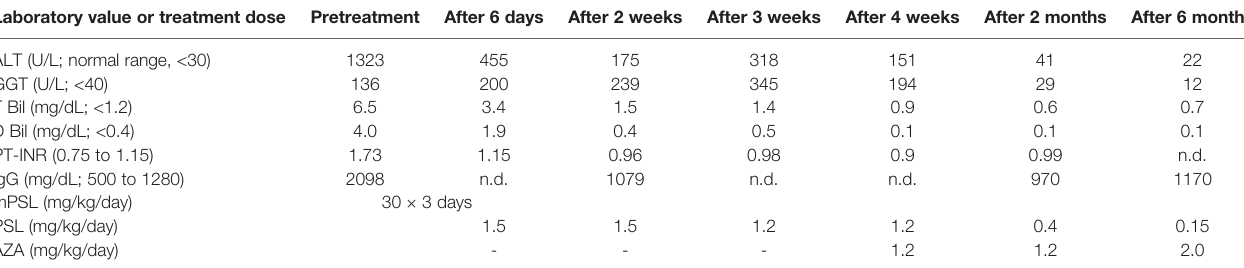
TABLE 1 | Clinical course of laboratory results and